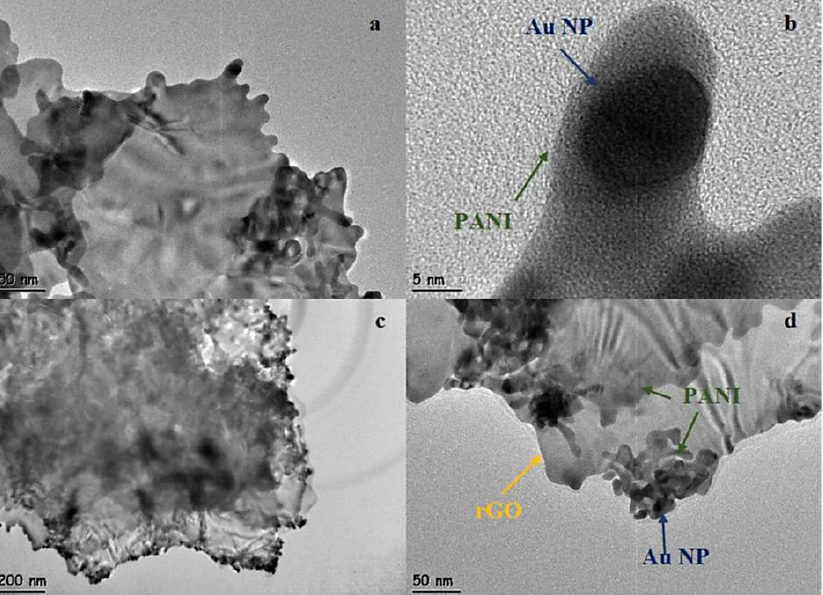
Figure 6. ( a – d ) HRTEM images of rGO-Au@PANI nanocomposite scanned at various resolutions [86]. rGO-Au@PANI = reduced graphene oxide-gold nanoparticle@polyaniline. Reproduced with permission from Elsevier.